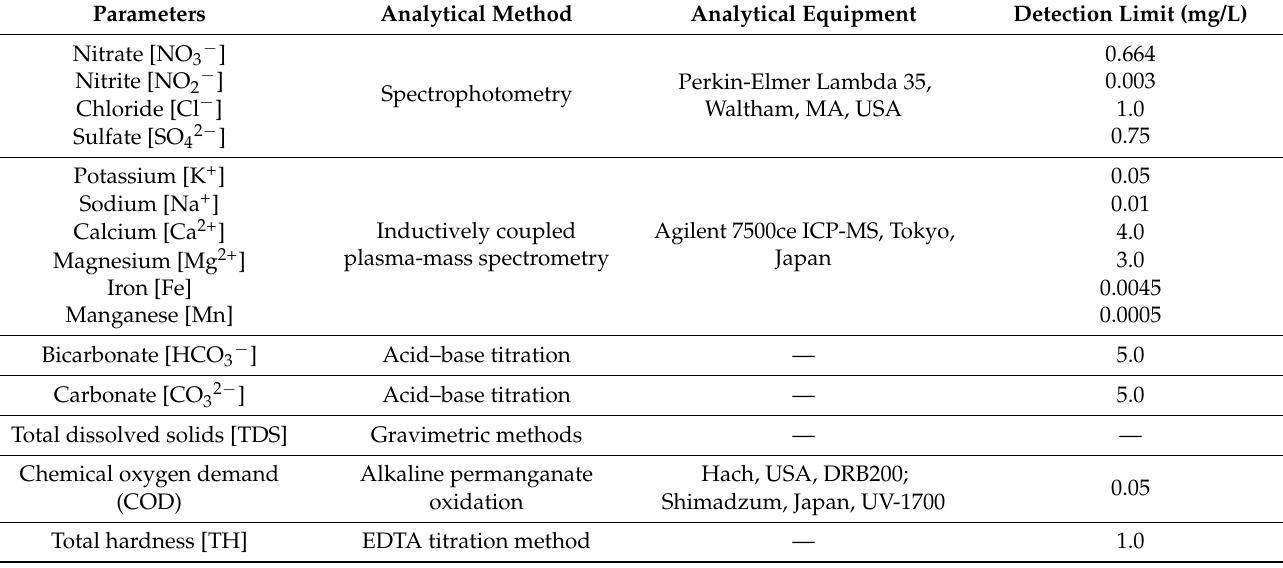
Table 1. Hydrochemical parameters, analytical method, equipment and detection